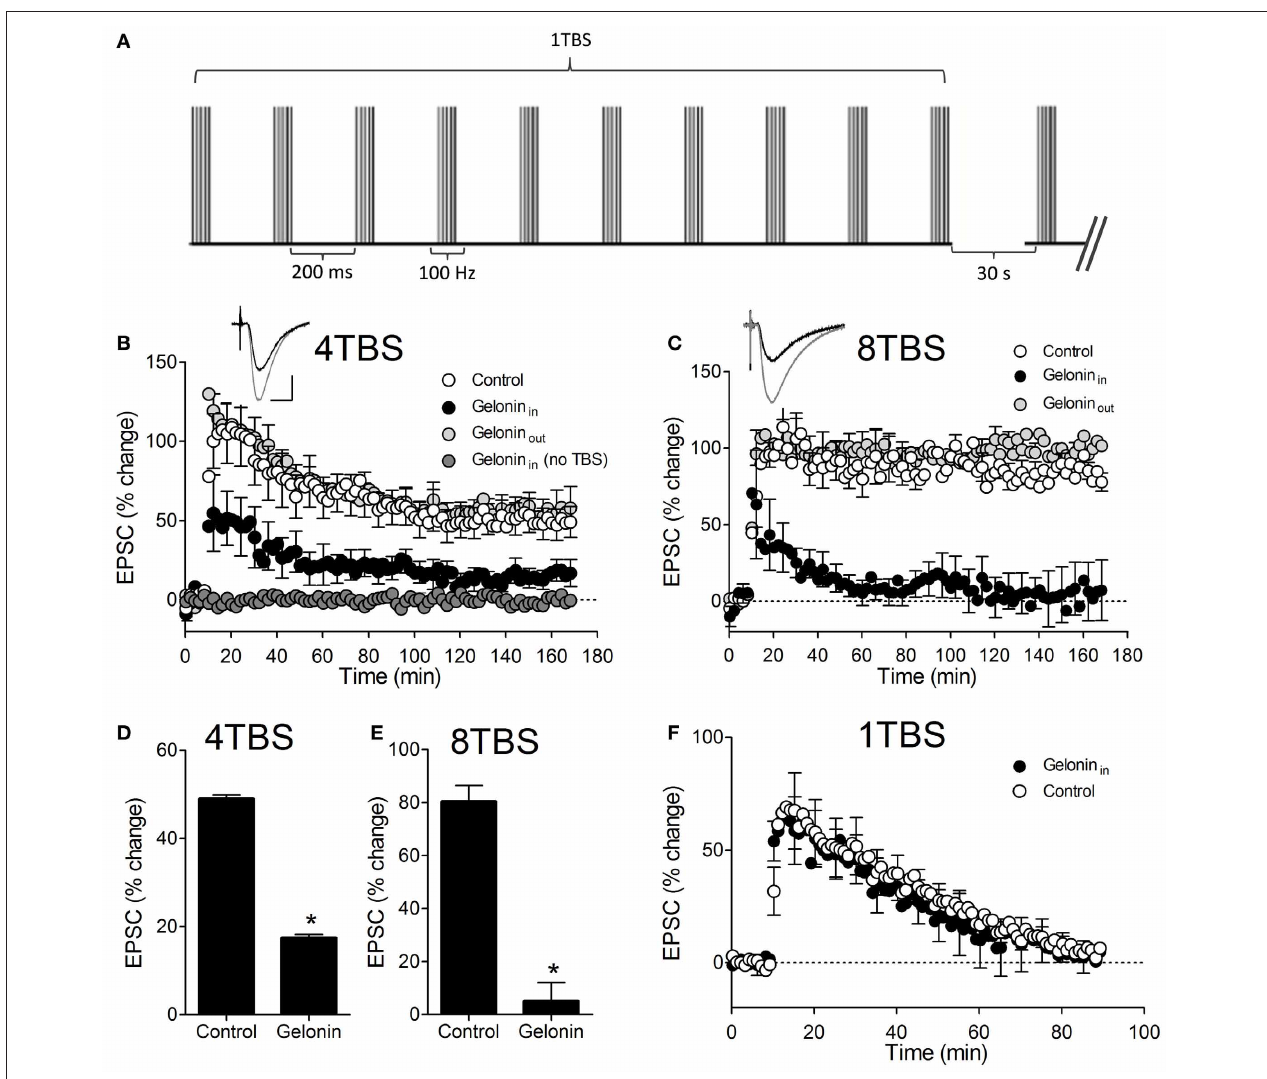
shows example EPSC traces before (black) and immediately after (gray) delivery of 4TBS or 8TBS in the control situation. Scale bar indicates 200 μ A and 10ms. Inclusion of gelonin in the patch pipette significantly reduced LTP magnitude at 160min post-4TBS (D) and post-8TBS (E) ( ∗ p < 0 . 05). Gelonin did not affect EPSC recordings in the absence of TBS (A) nor did it affect weak LTP1 induced by 1TBS (F) or LTP2 and LTP3 when applied extracellularly (gelonin out ) (B and C)